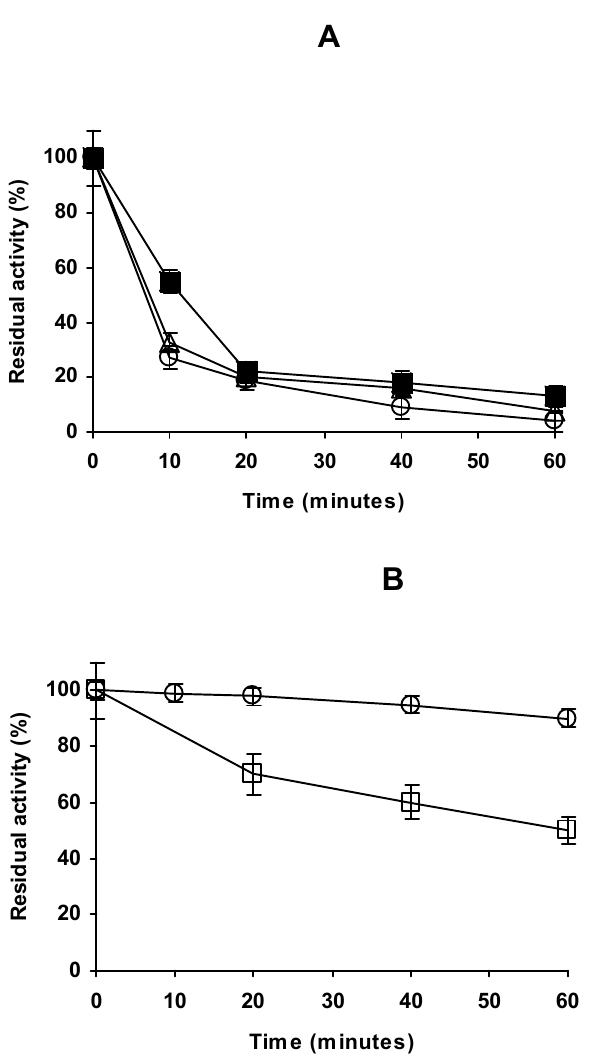
Figure 3. Effect on the enzyme activity of the incubation of: ( A ) β -gal-MANAE; or ( B ) free β -gal in the presence of glutaraldehyde. The experiments were carried out in 25 mM sodium phosphate at pH 7 and 25 °C. Other specifications are described in methods. A: (0.1% ( v / v ) glutaraldehyde). The support had 60 µ mol MANAE groups/g of support. All experiments were performed in triplicate and the values are given as mean value ± the experimental error. ( A ) Squares: β -gal was immobilized on MANAE-agarose at pH 5; Triangles: β -gal was immobilized on MANAE-agarose at pH 7; and Circles: β -gal was immobilized on MANAE-agarose at pH 9. ( B ) Squares: 1% glutaraldehyde; and Circles: 0.1% glutaraldehyde.